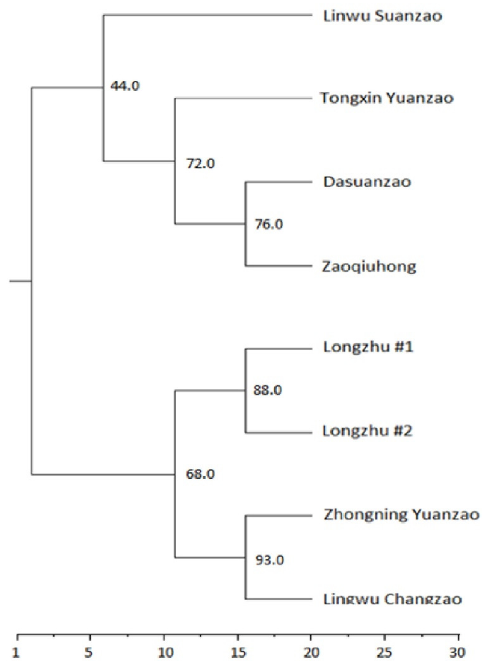
Figure 2. Principal Coordinate Analysis (PCoA) of the 24 jujube fruit samples from eight cultivars in Ningxia, China (Variation according to Coordinate 1 = 39.0%, Coordinate 2 = 27.9% and the third = 14.2%).